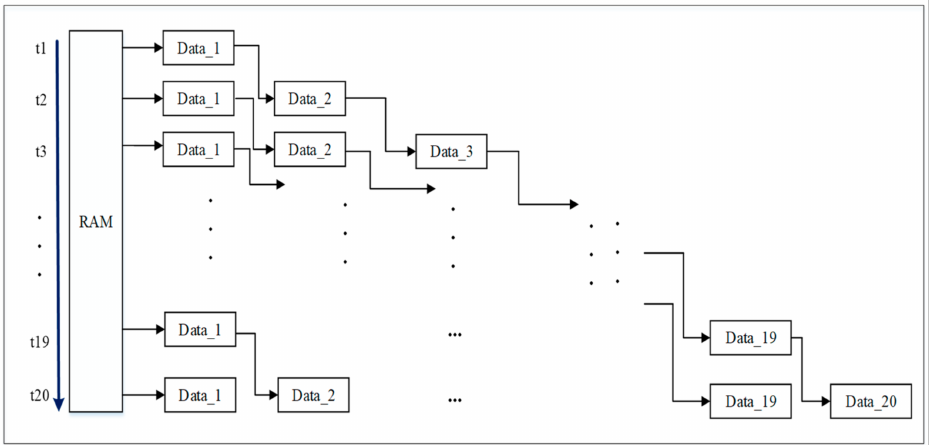
Figure 6. RAM data read